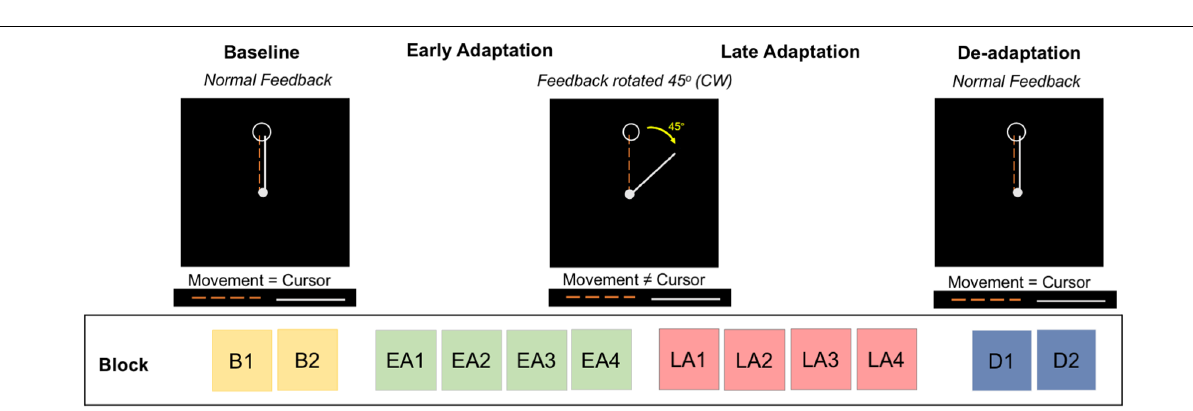
until it disappeared, and then (3) release the joystick to allow the cursor to re-center to the initial start